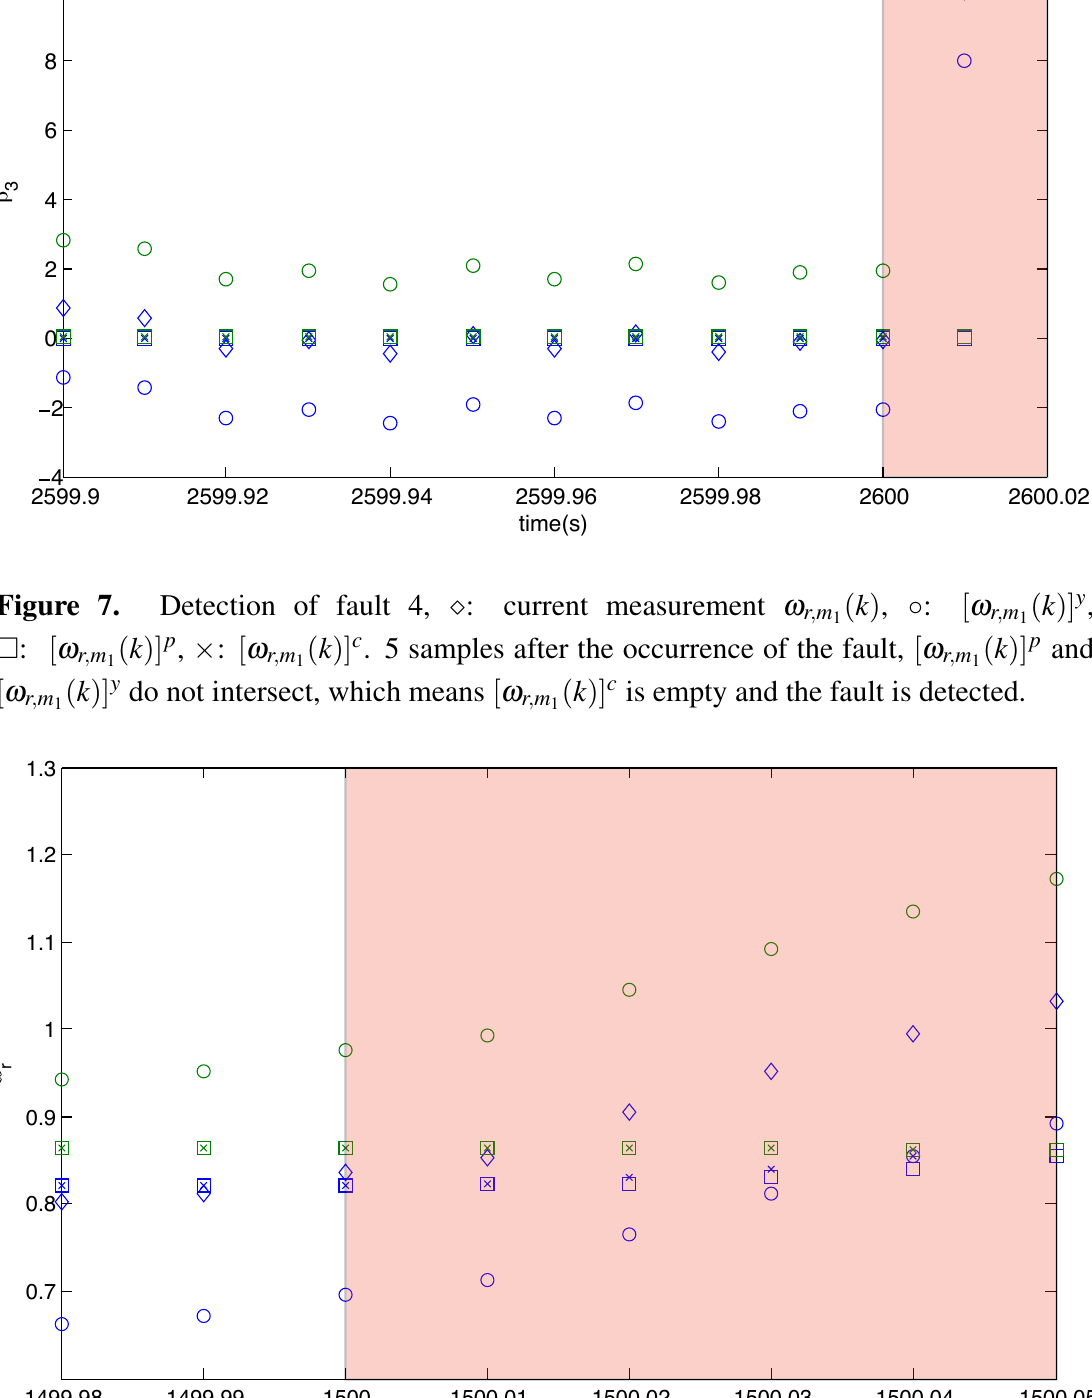
( k ) , ◦ : [ β ( k )] y , (cid:3) : [ β ( k )] p , 3 , m 3 3 ( k )] p and [ β ( k )] y do not 3 3